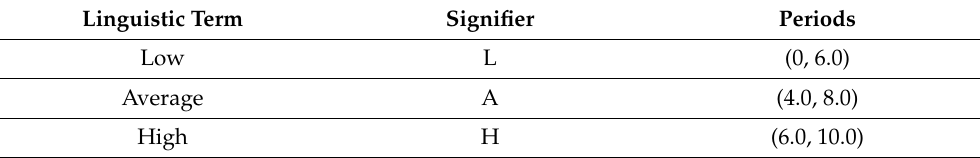
Table 4. Fuzzy set of input Participation in 3D VLE.